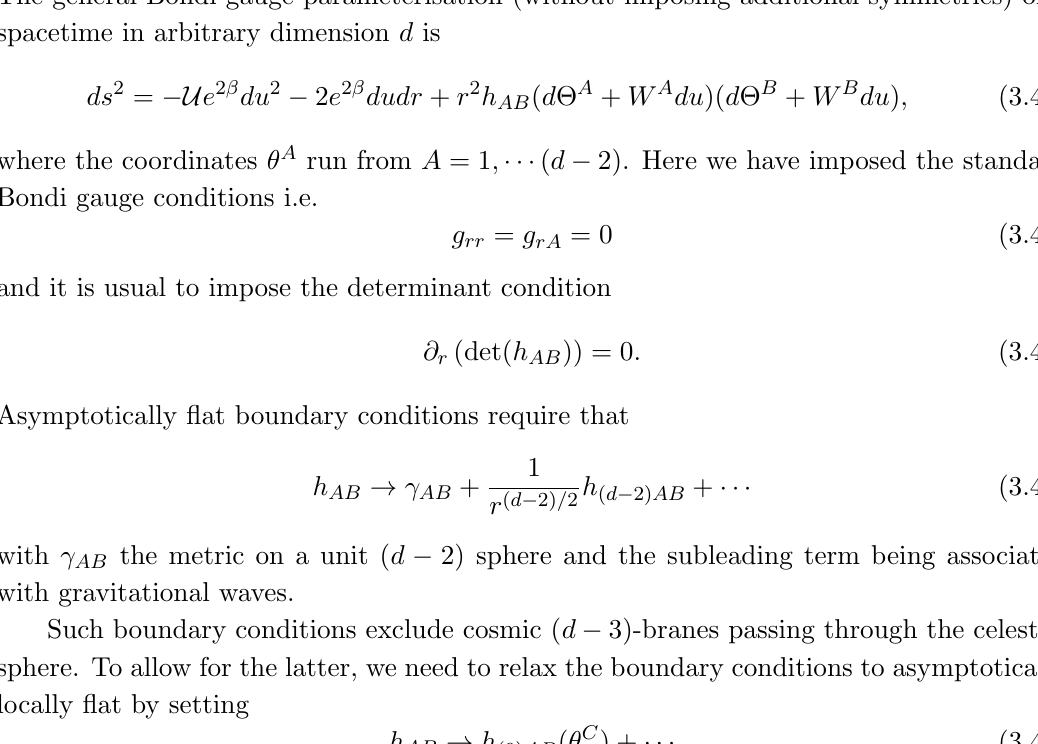
( (cid:18) ) for (cid:21) = 0 : (0)